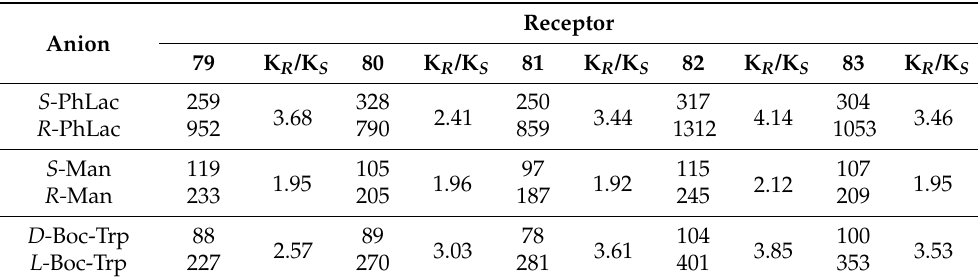
Table 5. Chiral recognition of amino acids as tetrabutylammonium salts by receptors 79 – 83 in